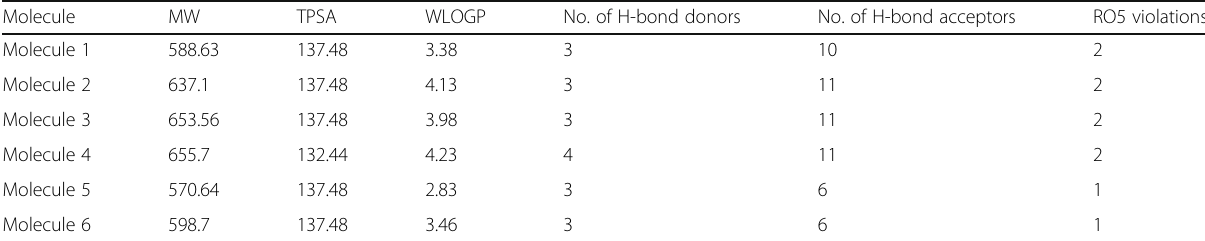
Table 7 Drug-likeness properties of the designed compounds Molecule MW TPSA WLOGP No. of H-bond donors Molecule 1